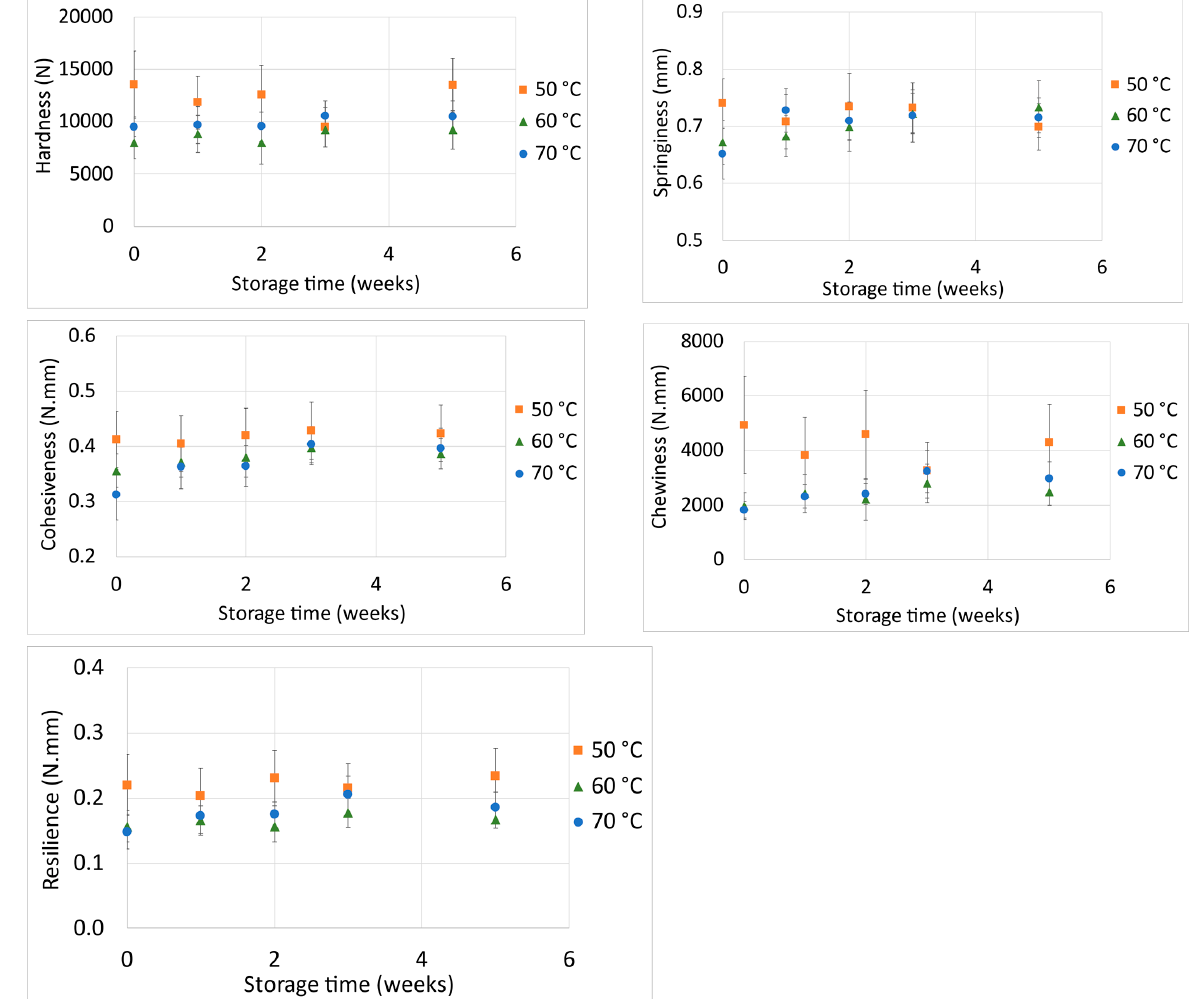
Figure 6. Hardness (N), springiness (mm), cohesiveness (N.mm), chewiness (N.mm) and resilience (N.mm) of bars processed at different temperatures relative to storage time (weeks).